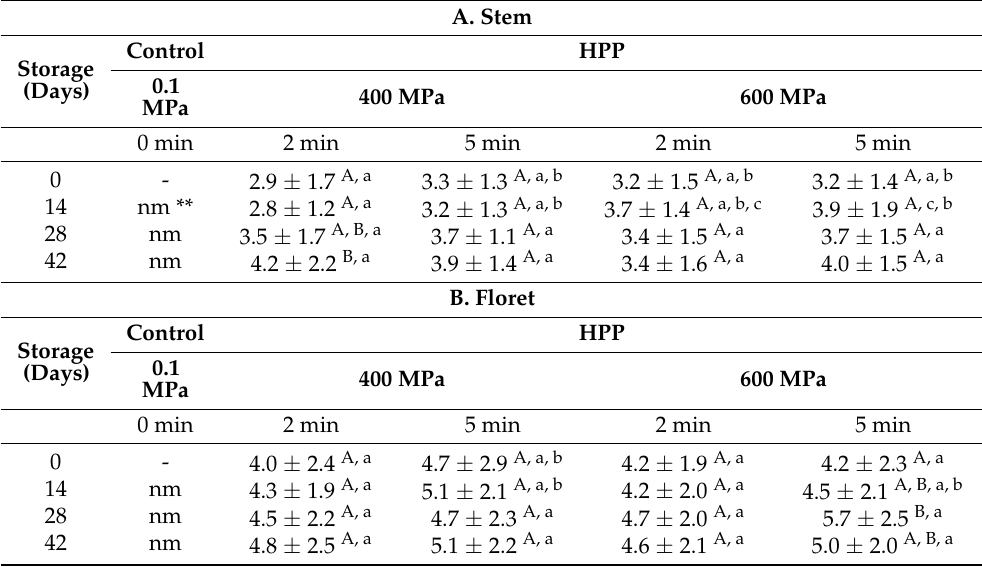
* Each color value (TCD) in the table is the mean ± standard deviation from processing parallel samples (n = 3). The capital letters (A and B) indicate significant differences ( p < 0.05, multiple Tukey’s adjusted analysis of variance) within the same treatment and storage time (same column). Small letters (a, b, and c) indicate significant differences ( p < 0.05, multiple Tukey’s adjusted analysis of variance) between different treatments (same